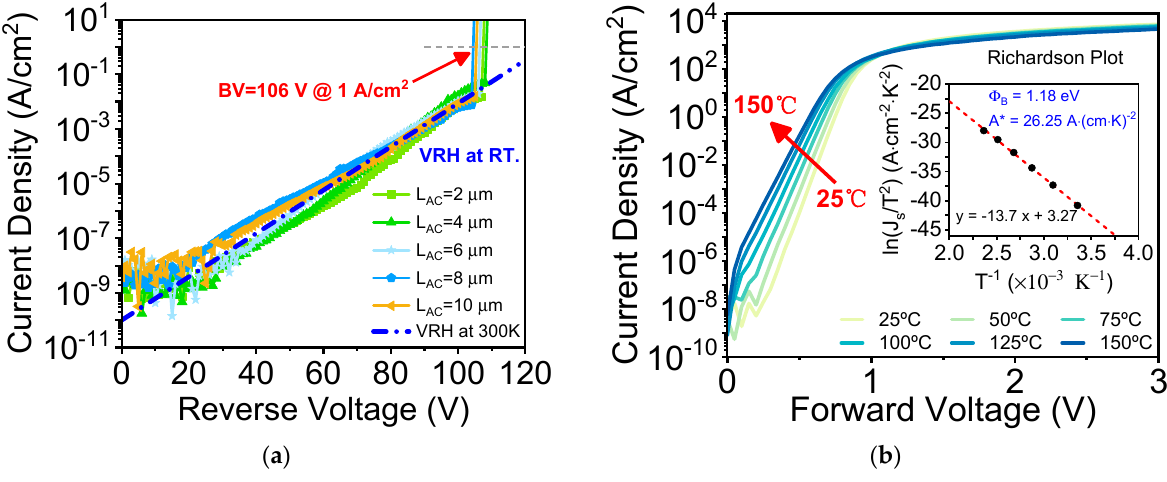
Figure 4. ( a ) Reverse I-V characteristics of the vertical GaN SBDs with various L AC . ( b ) Temperature-dependent I-V characteristics of the GaN SBD with L AC of 2 μ m in semi-log scale at temperatures ranging from 25 °C to 150 °C and corresponding Richardson plot (inset).